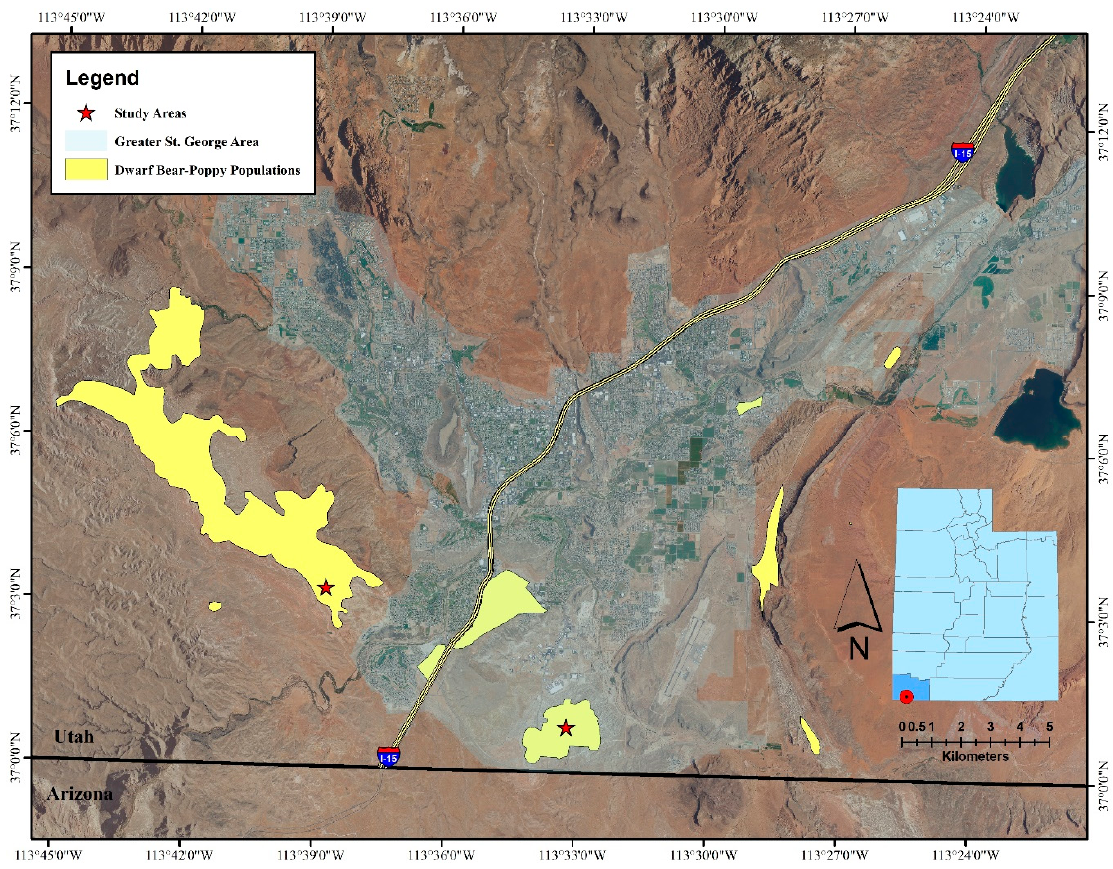
Figure 1. Range-wide distribution of Arctomecon humilis in southwestern Utah, USA [38], location of the two census areas, and boundaries of the Greater St. George Metropolitan Area.